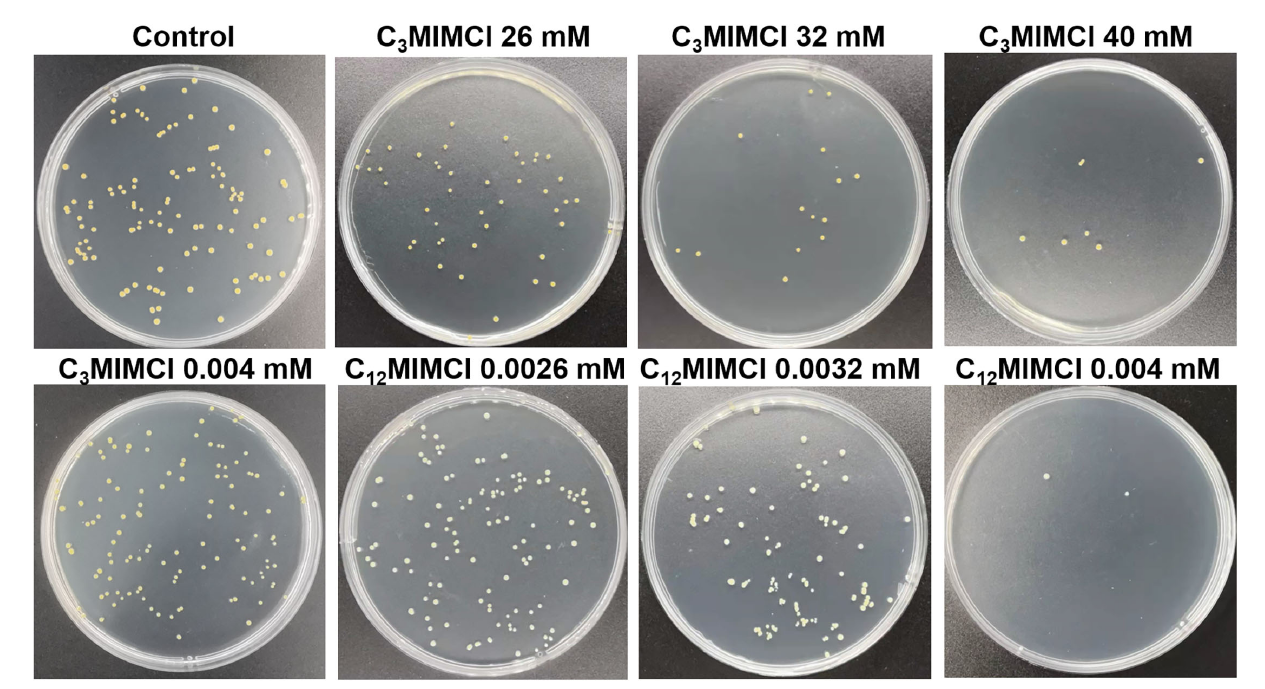
FIGURE2 Bacterial colony photos of Staphylococcus aureus incubated with various concentrations of C 3 MIMCl and C 12 MIMCl for 48h.